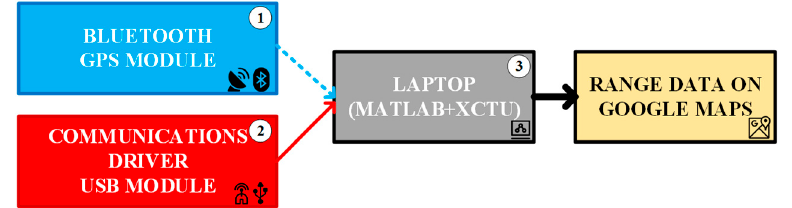
Figure 7. Diagram of the mobile system.